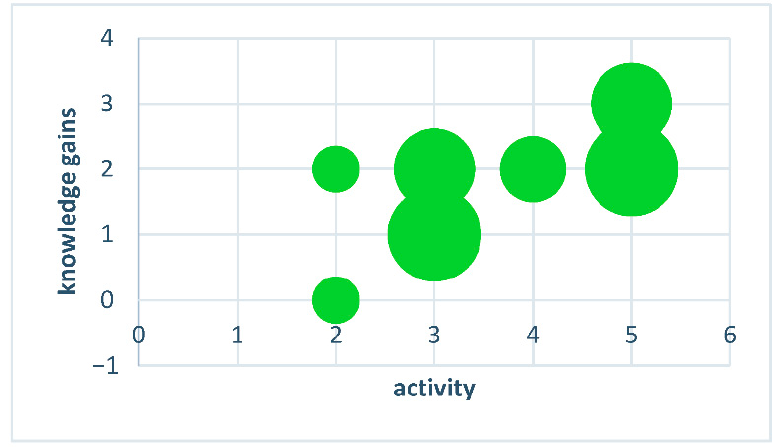
Figure 7. The relationship between participant activity and subjective knowledge gain. From the data in Figure 6, it can be read that the rated knowledge gain of the learners depends on their level of activity. The more active the listeners were, the better they rated the increase in their knowledge. The size of the bubbles corresponds to the number of respondents, so it can be seen that the largest proportion of them rated their activity at 3 or 5, and only two of the eighteen interviewees rated their activity at 2. Only one respondent to the questionnaire felt that her knowledge had not increased as a result of the training, but she herself admitted that her level of involvement in the training was the